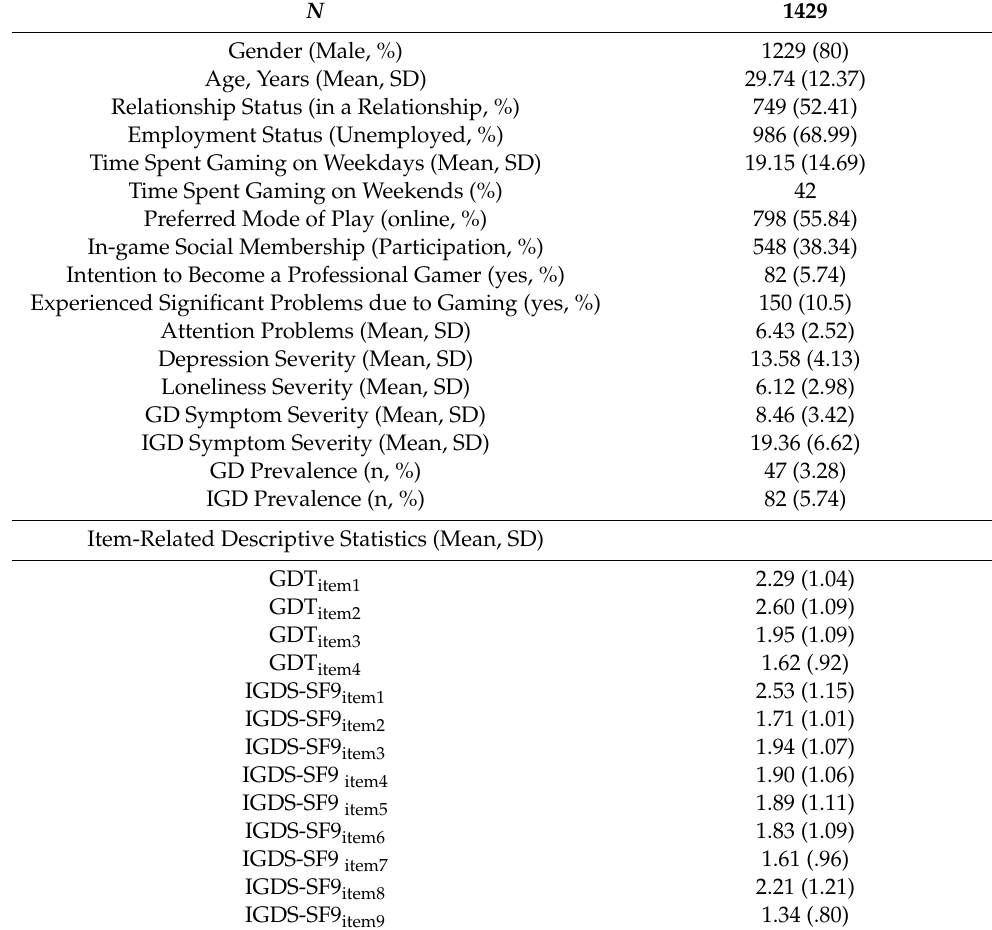
Table 1. Main sociodemographic characteristics and related gaming behaviors among the